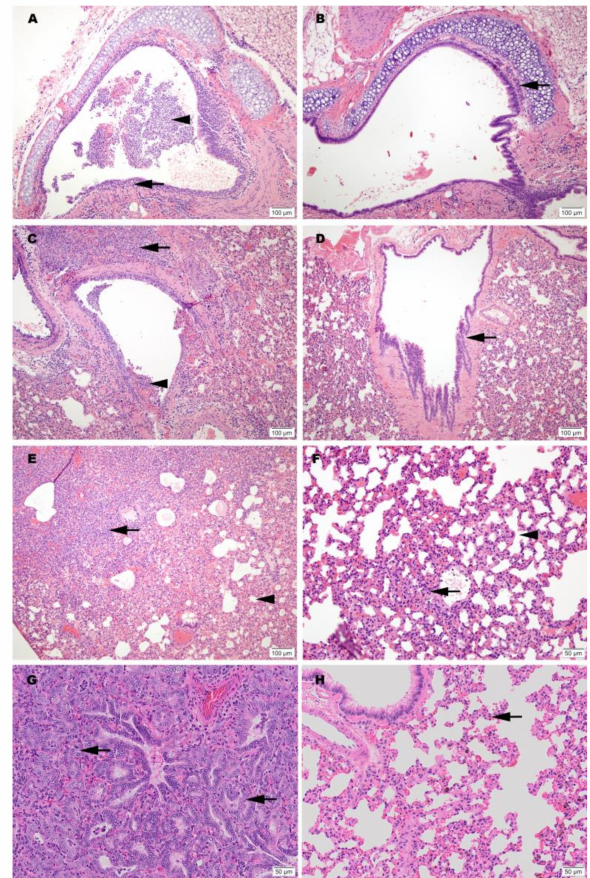
Figure 4. Representative histology of differences between unimmunized SARS-CoV-2 infected con- trols ( A , C , E , G ) and infected hamsters vaccinated with SolaVAX prepared SARS-CoV-2 virus and CpG 1018 adjuvant ( B , D , F , H ). Images A-F are taken at 3 dpi and images G-H are taken at 7 dpi. ( A ) Trachea with dense submucosal lymphocytic and neutrophilic inflammation infiltrating mucosal epithelium (arrow) and accumulation of neutrophils within the tracheal lumen (arrowhead). ( B ) Tra- chea with mild submucosal lymphocytic inflammation. ( C ) Large bronchus with dense lymphocytic and suppurative inflammation in the interstitium (arrow) and accumulation of neutrophils in the lumen with loss of mucocal epithelium (arrowhead). ( D ) Large bronchus minimally affected by inflammation (arrow). ( E ) Effacement of lung alveolar tissue by consolidating interstitial pneumonia (arrow) and overall decrease in alveolar air space (arrowhead). ( F ) Interstitial pneumonia increasing alveolar wall thickness (arrowhead) without compromising alveolar air space (arrowhead). ( G ) Lym- phocytic interstitial pneumonia surrounds dense pneumocyte epithelial regeneration (arrows) at day 7 of infection. ( H ) Minimal evidence of interstitial pneumonia (arrow) and an absence of epithelial